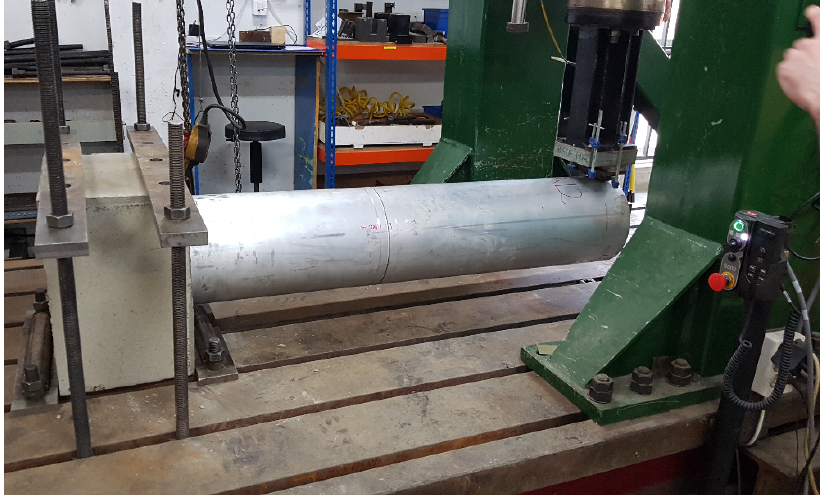
Figure 3. Experimental setup.